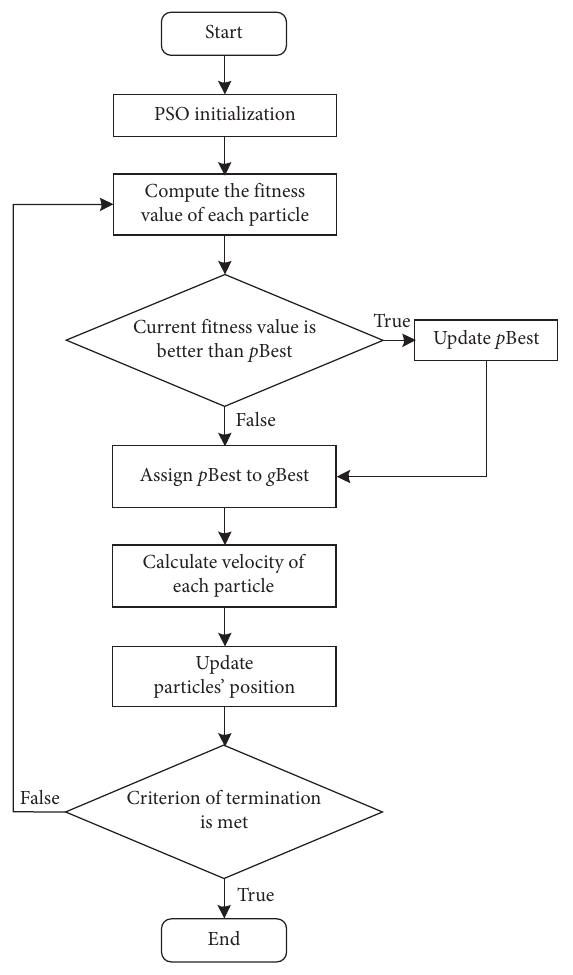
Figure 2: Flowchart of the PSO